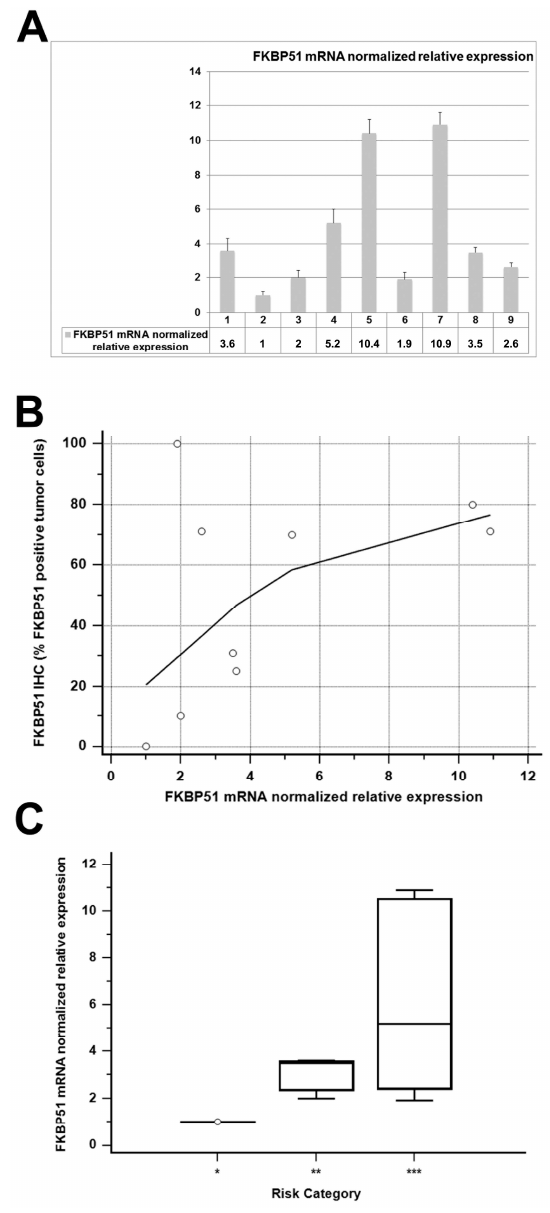
Figure 5. ( A ) FKBP51 mRNA normalized relative expression in nine representative cases; ( B ) scatter plot showing the relationship between FKBP51 mRNA normalized relative expression and FKBP51 IHC results (expressed as % of positive tumor cells); ( C ) box plot sowing the FKBP51 mRNA normalized relative expression distribution over the three patients’ risk categories (*, **, *** as defined by survival curves in Figure